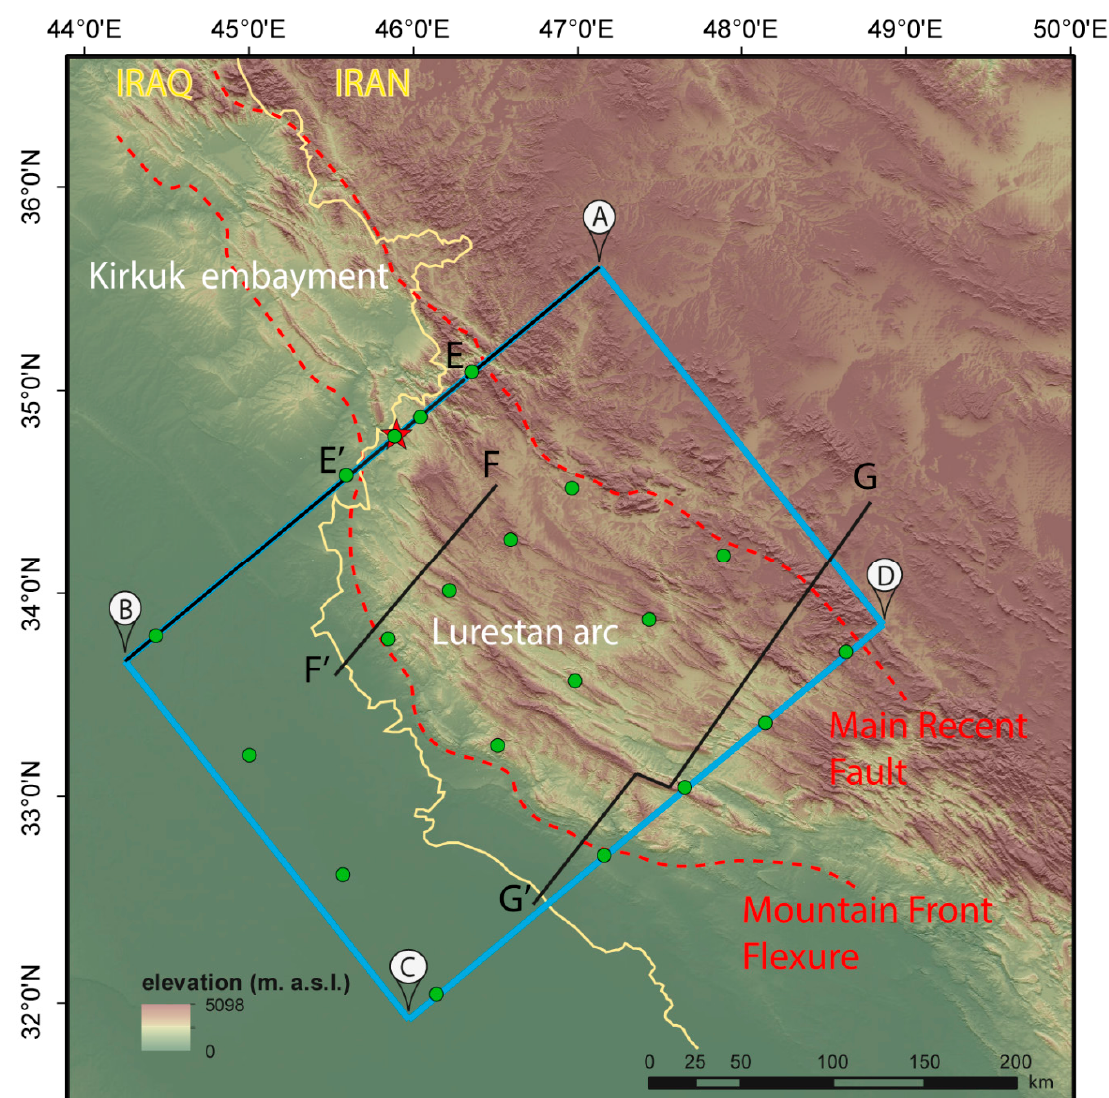
Figure 3. Sketch map of the Lurestan arc. The yellow line represents the political boundary between Iraq and Iran. The blue rectangle is the area of the 3-D geological model shown in Figure 4, having vertexes A, B, C, and D. Black lines show the traces of published geological sections: (1) A - B by Basilici et al. [12], (2) E - E’ by Tavani et al. [13], (3) F-F’ by Tavani et al. [14], and (4) G-G’ by Vergés et al. [4]. Red, dashed lines are the traces of faults included in the geological 3-D model. Green points show location of the pseudo-wells used to implement the analytical procedure. Red star is the epicentral position of the main seismic event of 12 November 2017 (M w = 7.3) [13].